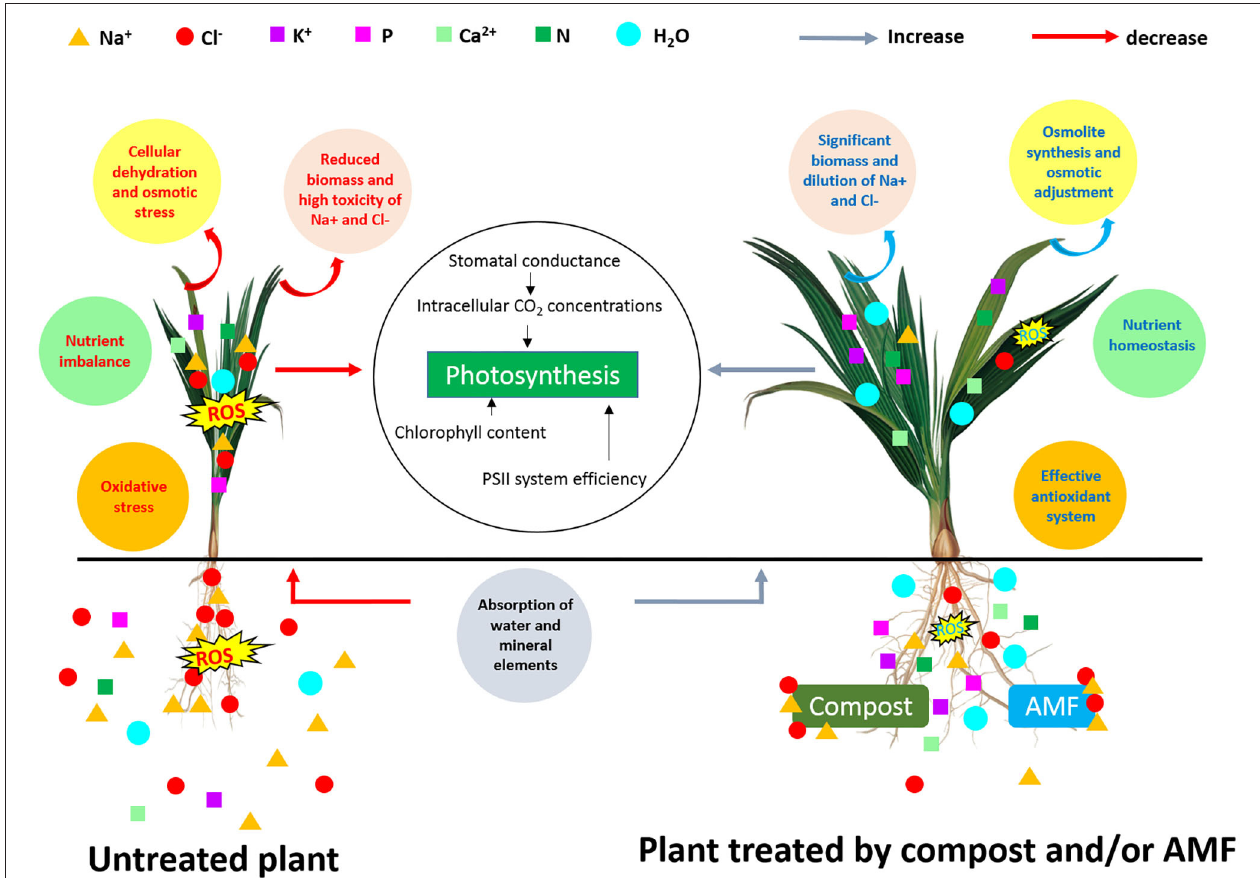
FIGURE 5 | Schematic representation of various mechanisms induced by AMF and compost application in date palm plants under salt